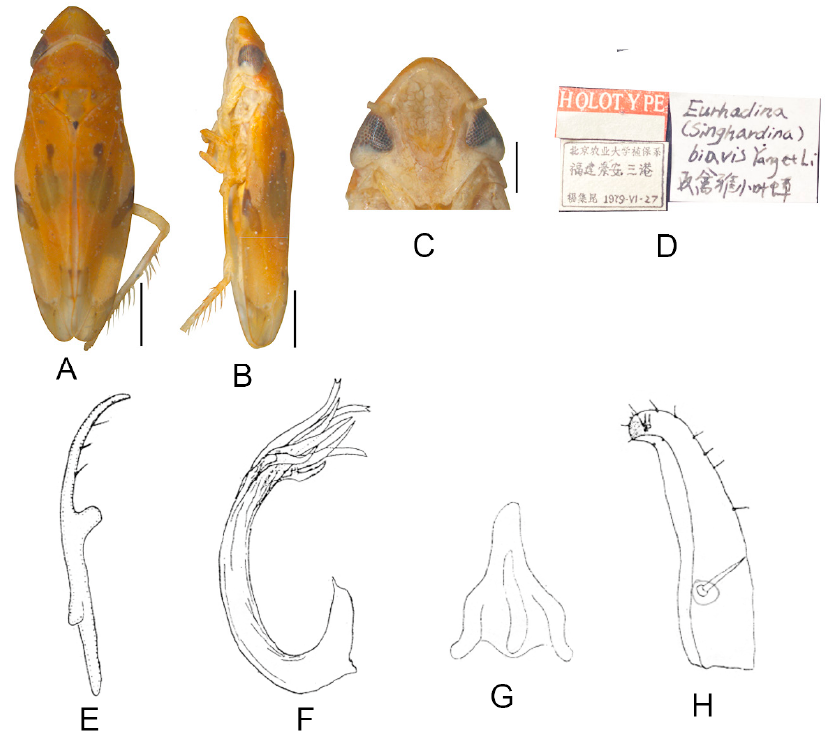
Figure 11. Eurhadina ( Singhardina ) biavis ( A – D : holotype; E – H : Yang et Li, 1991 [12]): ( A ) habitus, dorsal view; ( B ) habitus, lateral view; ( C ) face; ( D ) labels of the holotype (China, Fujian Prov., Chongan, Sangang, 1979.VI.27, coll. Jikun Yang); ( E ) paramere, dorsal view; ( F ) aedeagus, lateral view; ( G ) connective, dorsal view; and ( H ) subgenital plate, dorsal view. Scale bars: 0.5 mm. Notes. We compared the habitus, detected genitalia, and illustrated figures of the holotype specimen of E. ( S. ) biavis Yang et Li [12] with Eurhadina rubromia as described by Cai et Kuoh in 1993 [9], and found their localities are all in Fujian and possess identical characteristics: yellowish orange body, scutellum with apex blackish , central clavus with a big black irregular patch like a waterfowl, the aedeagus with three pairs of apical ap- pendages, dorsal appendages of aedeagal shaft bi-forked apically, and ventral ones branched basally. We therefore consider them to be the same species and, according to the rule of ICZN, we propose Eurhadina rubromia Cai et Kuoh as a junior synonymy to E. ( S. ) biavis Yang et Li.